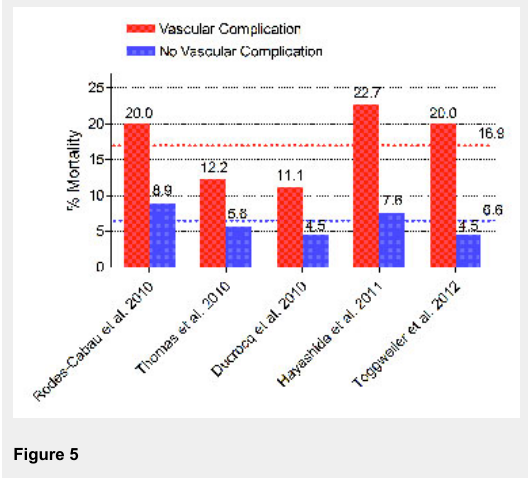
Impact of vascular complications on 30-day mortality. 30-day mortality in patients with a (major) vascular complication was consistently higher than in those without. In pooled analysis of all 5 studies including >1000 patients, mortality was 16.9% (red dotted line) and 6.6% (blue dotted line) in patients with and without vascular complications.